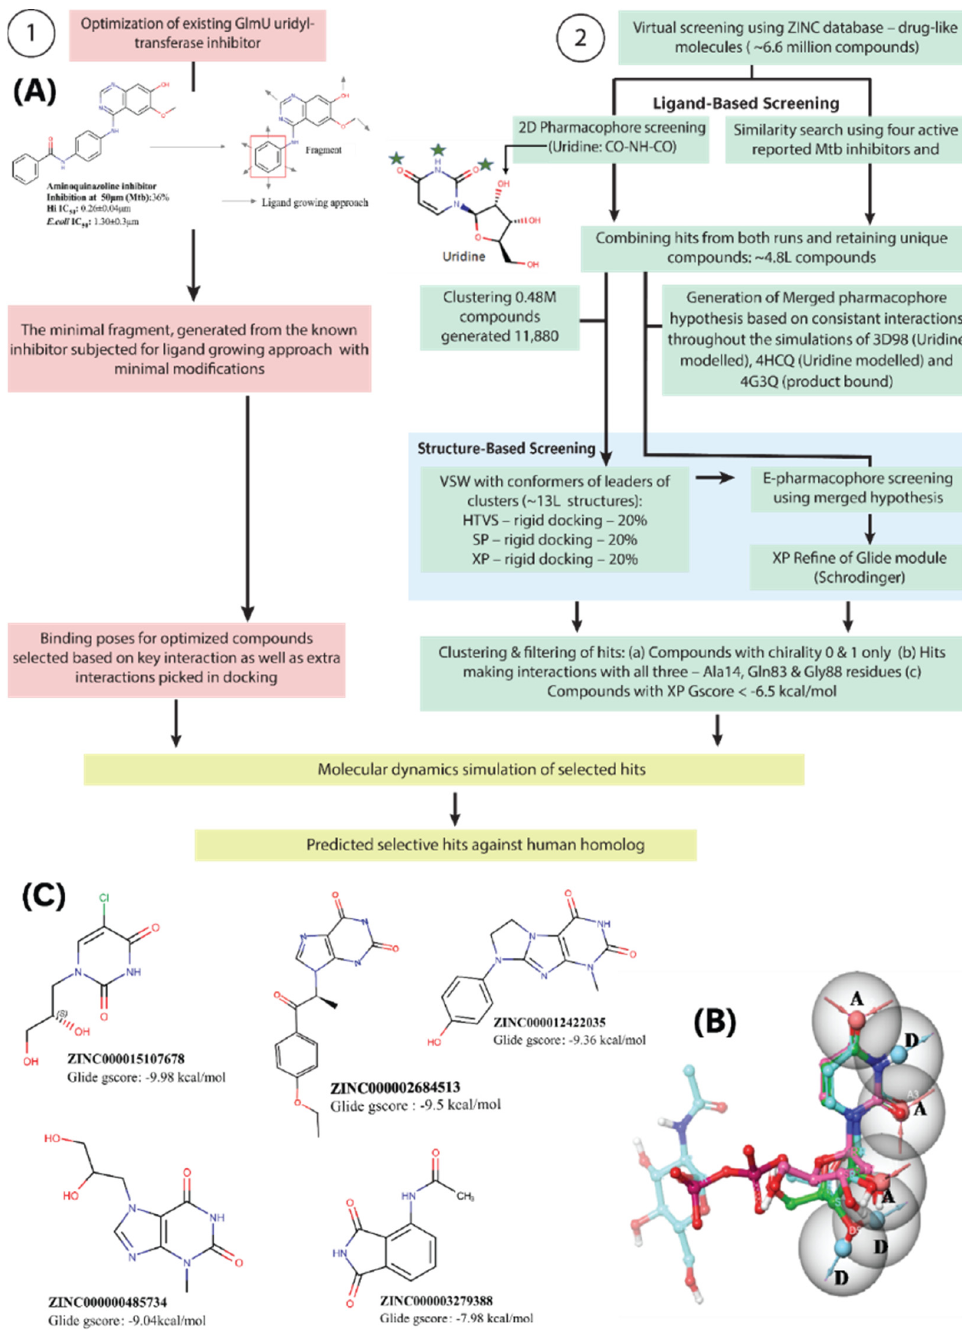
Figure 3. ( A ) The two compounds which were tested on all three organisms Mtb, HI and E. coli [2,19]. Compound 1 superposed on to E. coli and MtbGlmU pocket. The pocket volumes of apo forms of three organisms generated using CASTp server [17] visualised by MSMS package of Chimera [18]. ( B ) Binding poses of compound A and compound E. ( C ) MD simulation analysis of compound A and E.